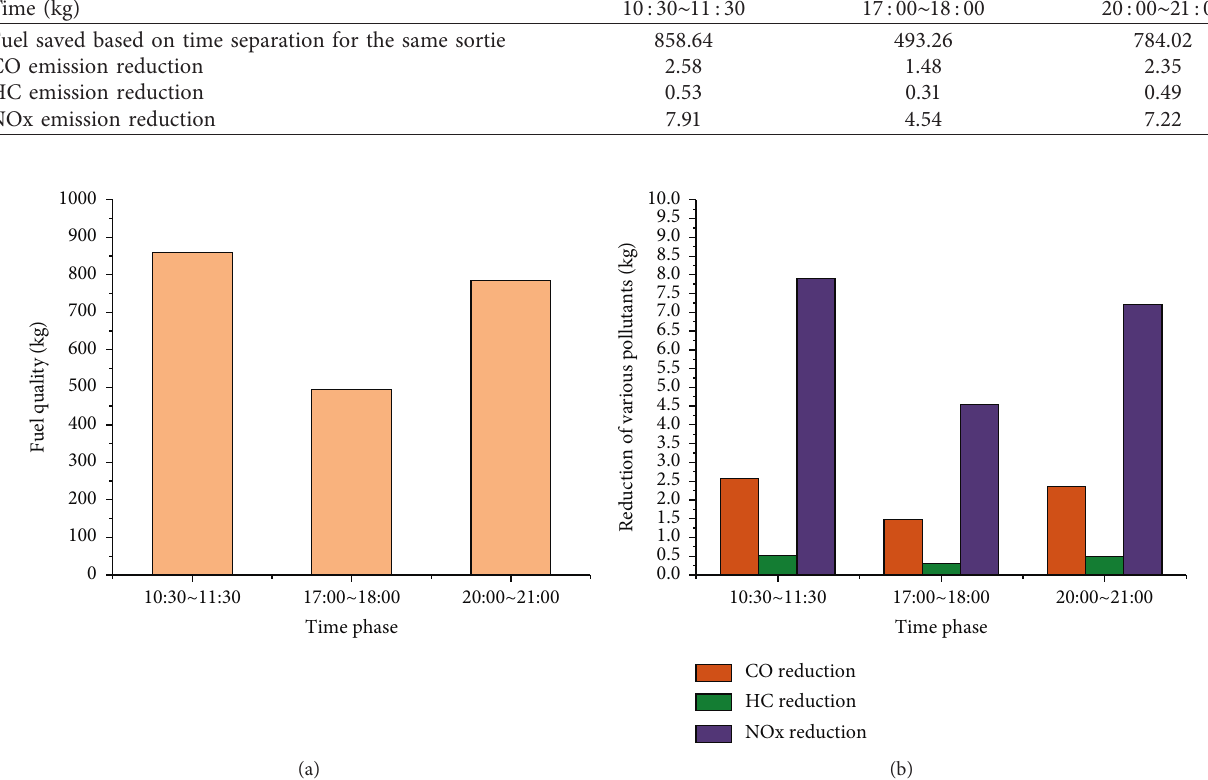
Figure 9: Emission reduction histogram and fuel saved of various pollutants. (a): Under the same entry capacity, the fuel quantity is reduced by TBS operation mode in three time periods. (b): Under the same entry capacity, the pollutant emission is reduced by TBS operation mode in three time